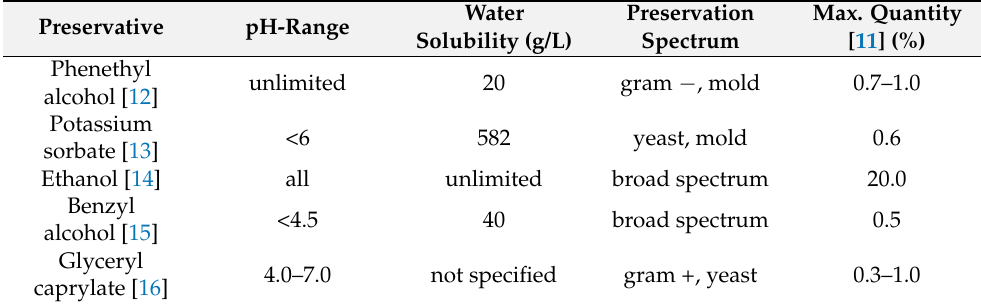
Table 1. Overview of selected